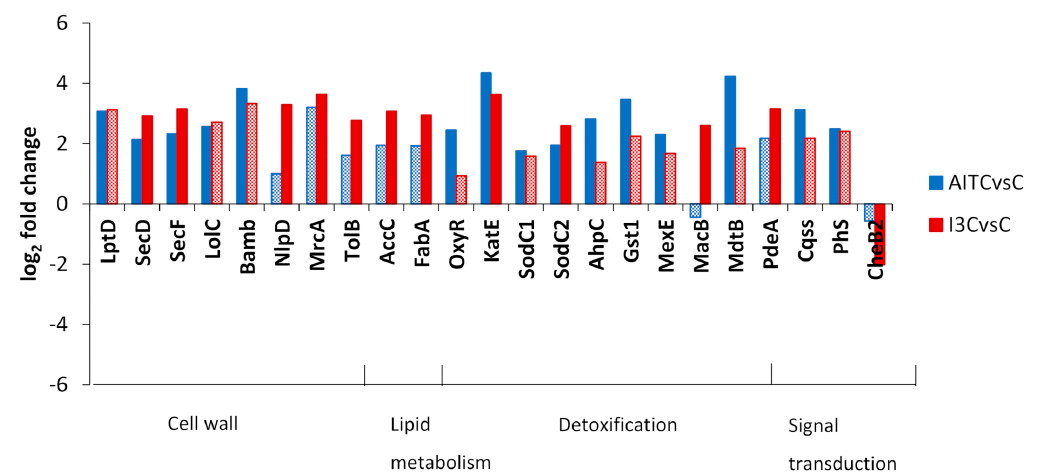
Figure 5. Log 2 fold change of DEGs classified into KEGG categories of cell wall, lipid metabolism, detoxification, and signal transduction in the comparisons of AITC vs. the control and I3C vs. the control. Solid colours of the bars indicate a false discovery rate ≤ 0.05. A description of DEGs is provided in Supplementary Tables S1 and